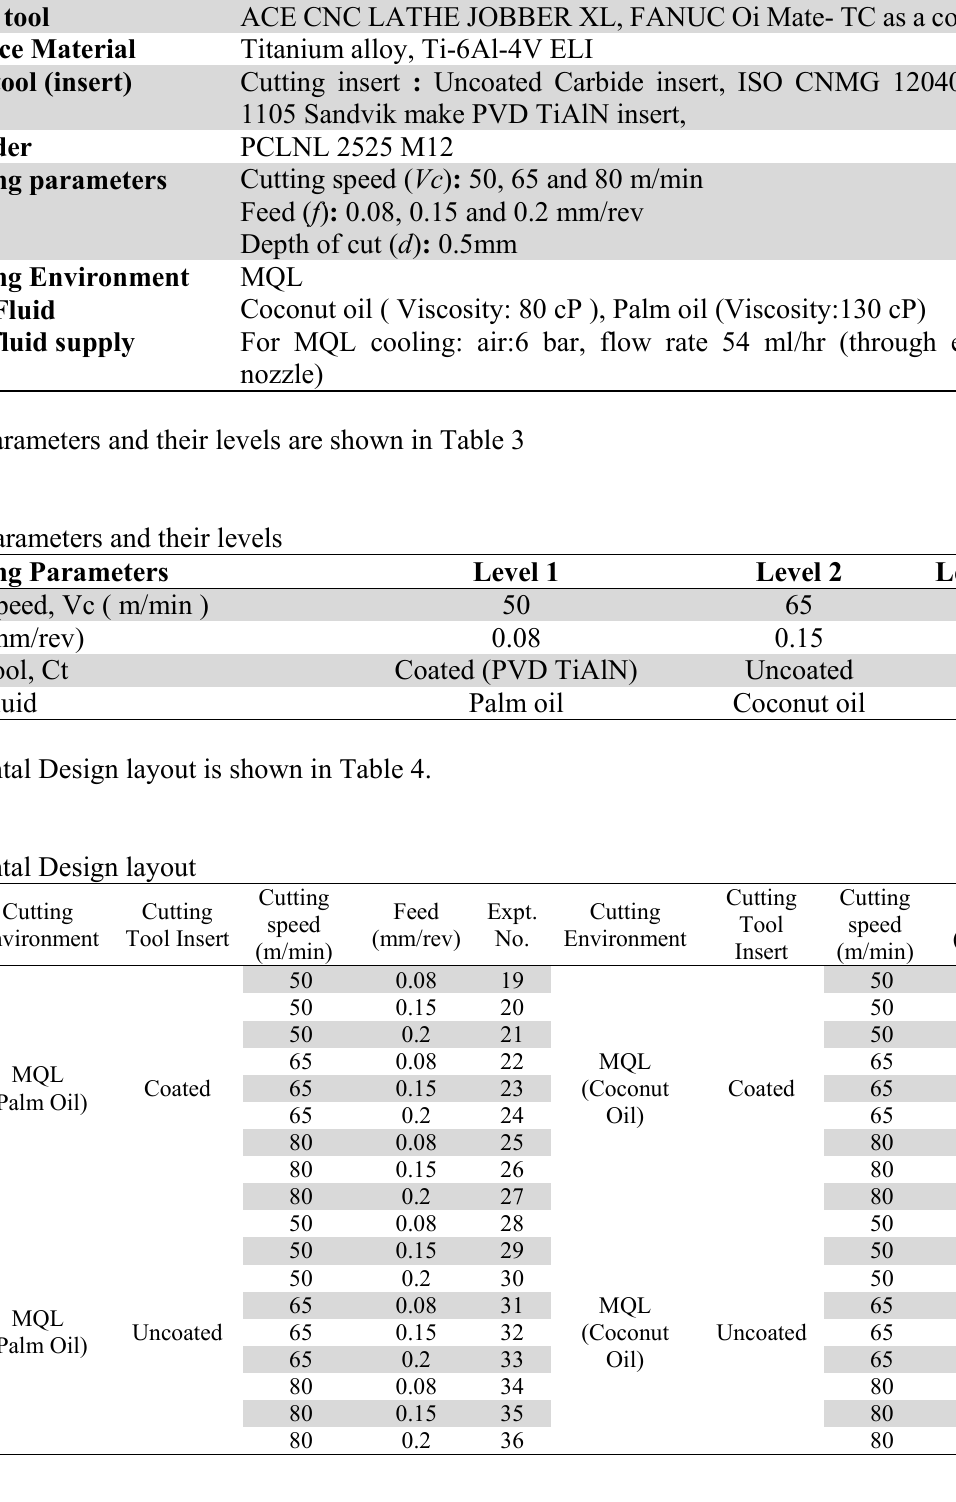
Cutting condition for experimental works Machine tool